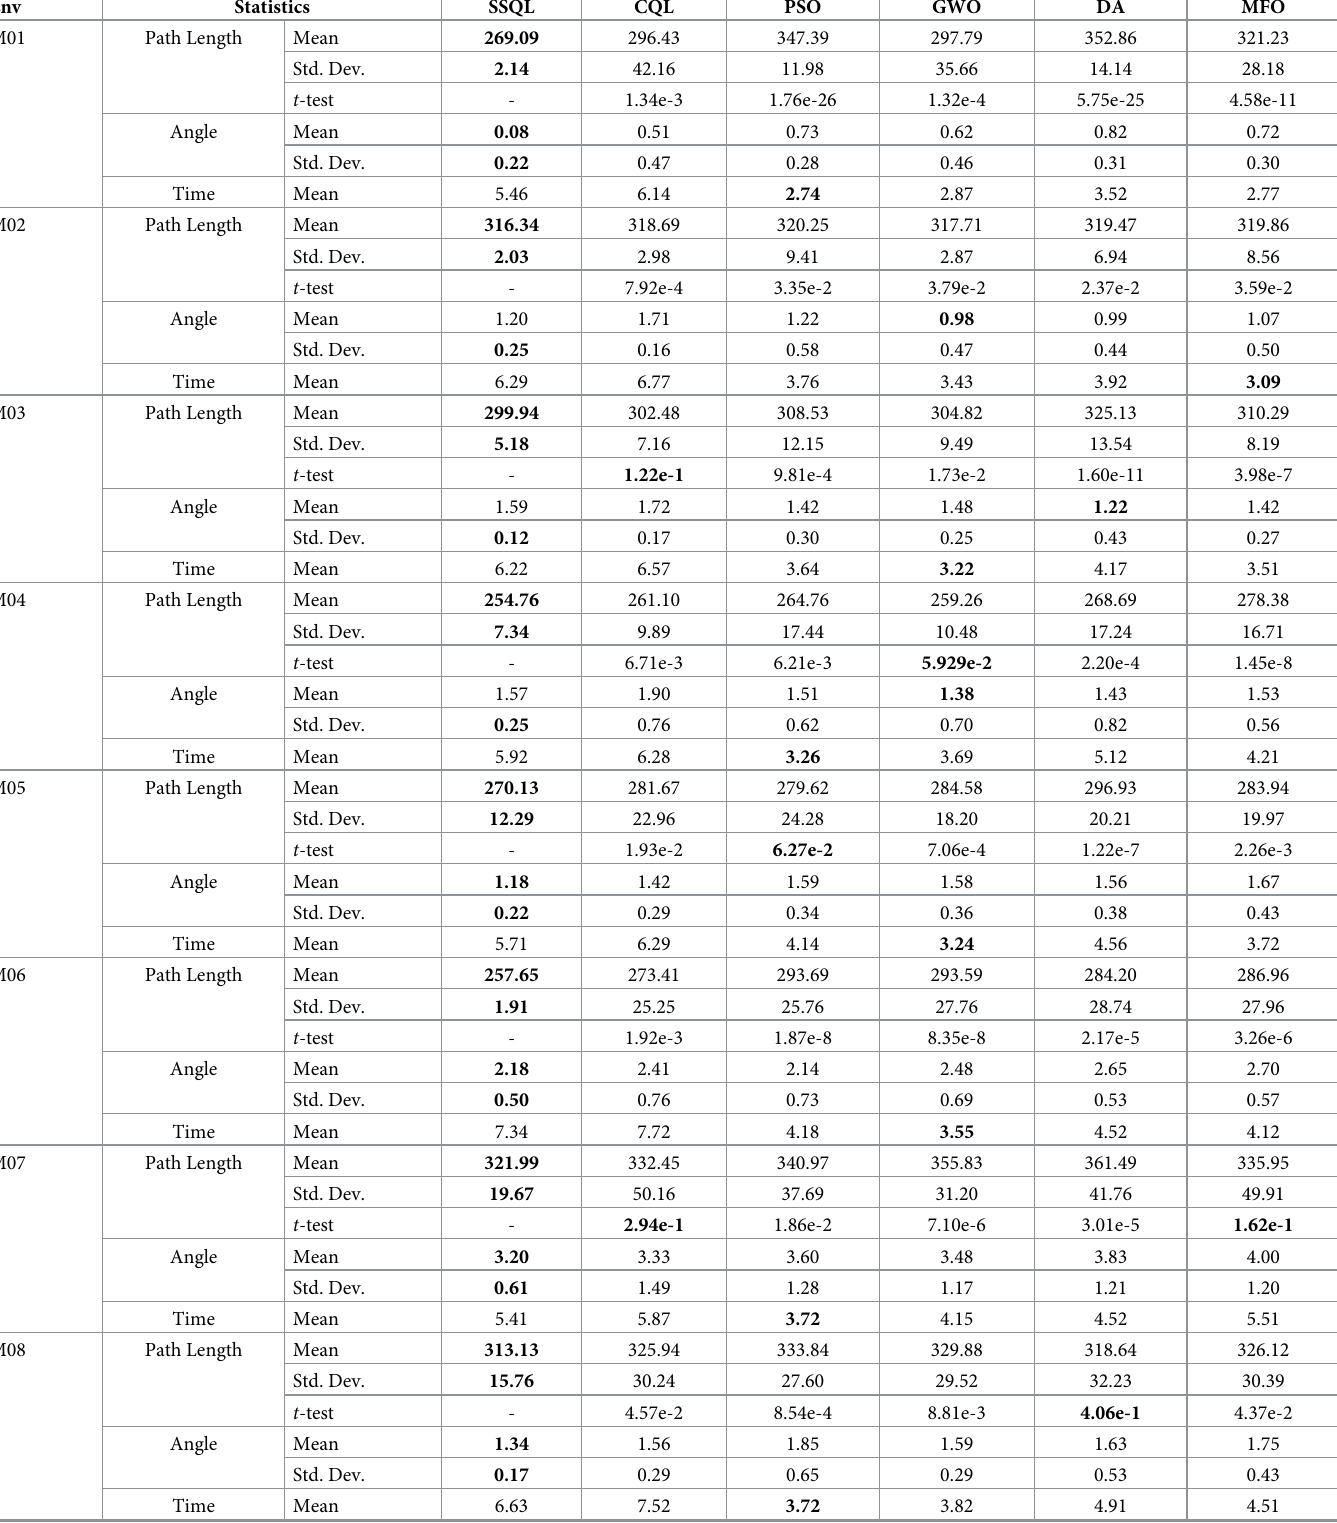
Table 3. A comparison between SSQL, CQL, PSO, GWO, DA and MFO for safe path planning. The lowest (best) both mean, standard deviation, and the values of path length bigger than the level 0.05 of significance are highlighted. Env M01 Path Length